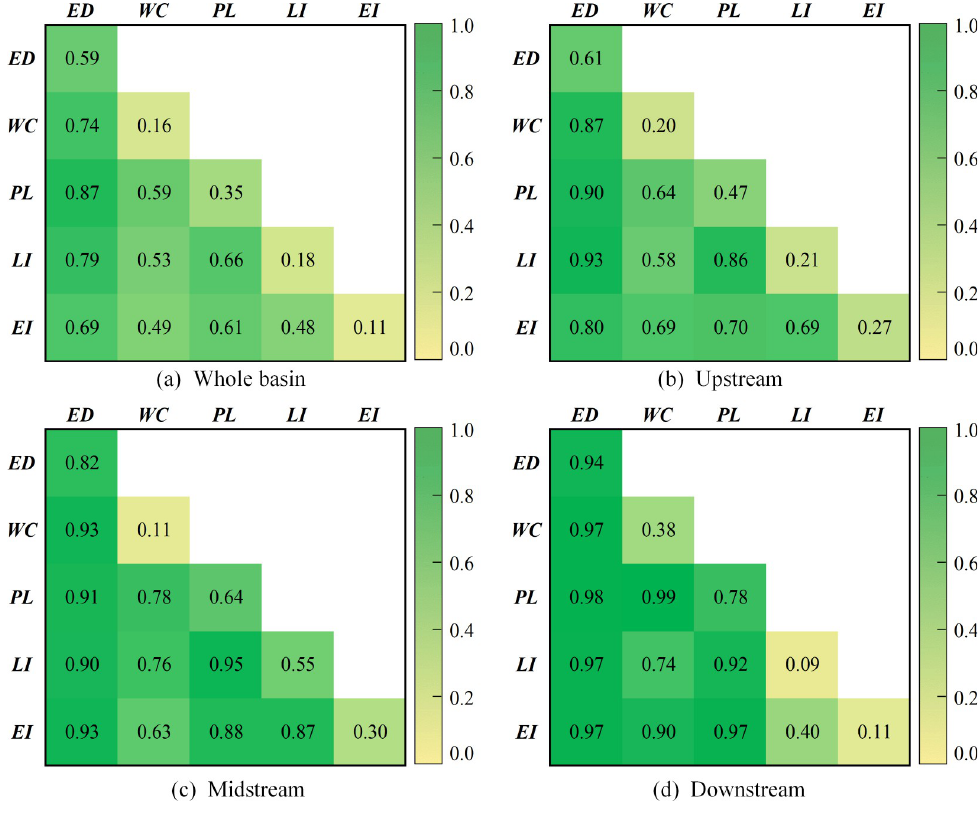
Fig 6. Detection results of the interaction of internal